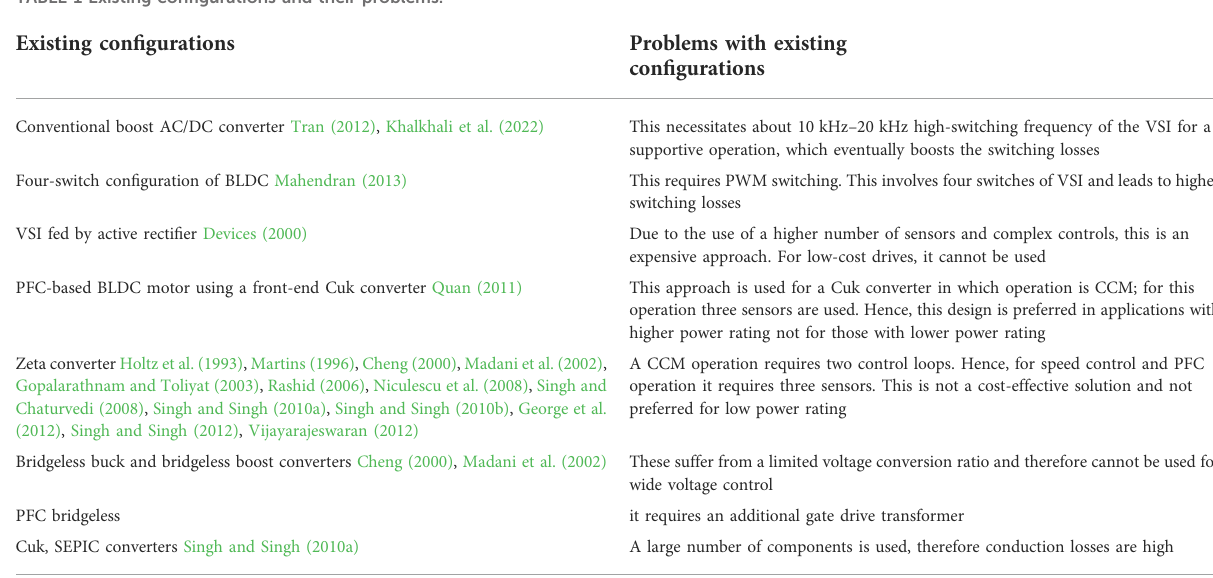
TABLE 1 Existing con fi gurations and their